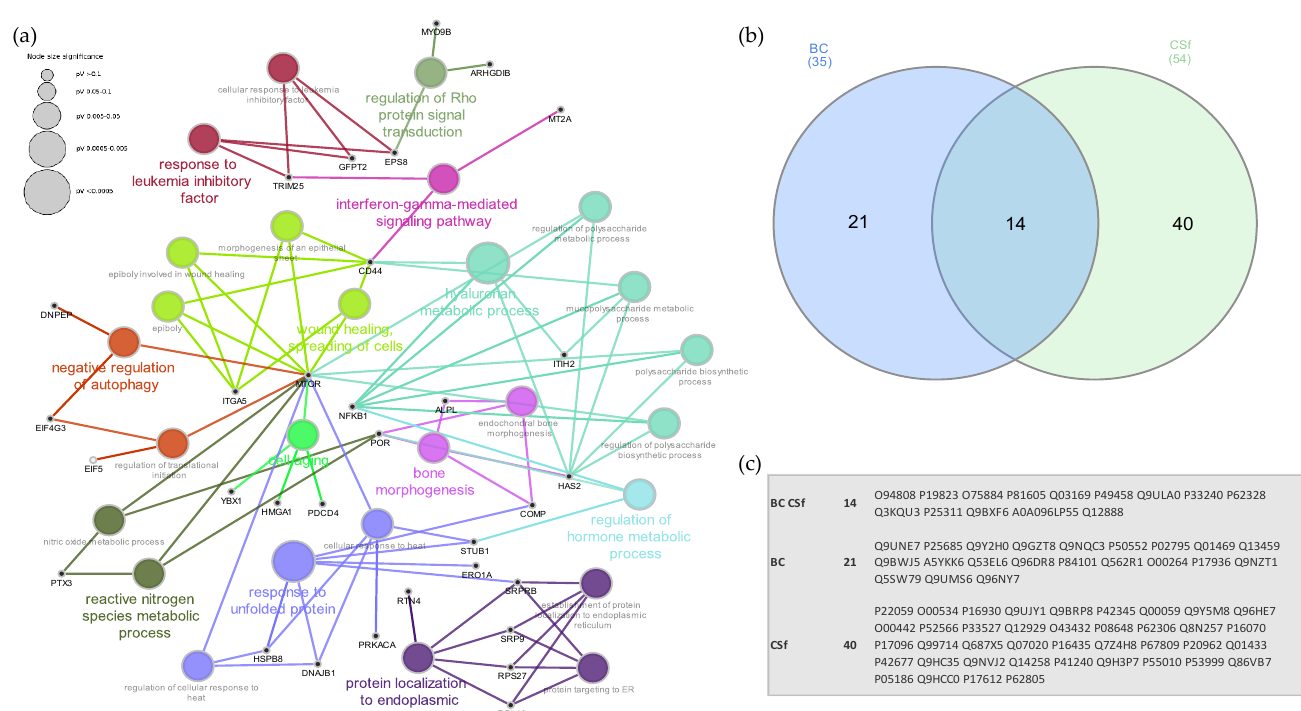
Figure 4. ( a ) Enriched GO network groups using ClueGO/CluePedia-based enrichment. A network view for GO Biological Processes of differentially regulated proteins following BC and CS f treatments. Terms (each represented as node) are functionally grouped based on shared genes (kappa score ≥ 0.4) and are shown with different colors representing the class to which they belong. The specific players (proteins) of each node are highlighted with the respective gene name (in black). The size of the nodes indicates the degree of significance. Within each class, the most significant term (indicated with colored and bold characters) defines the name of the group. Ungrouped terms are not shown. ( b ) Venn diagram showing the overlapping of differentially expressed proteins after BC (blue) and CS f (green) treatments. Details of the UniProt accession numbers within each subset of the Venn diagram are reported in ( c ).